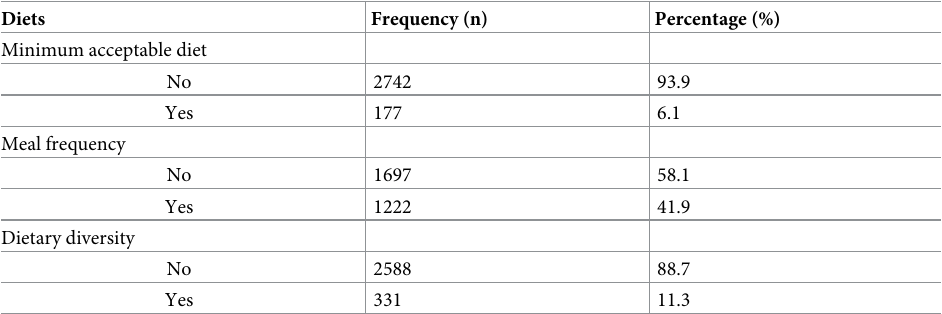
Table 4. Minimum meal frequency, Dietary diversity and minimum acceptable practice among children 6–13 months of age in Ethiopia, 2016 (n = 2919). Diets Frequency (n) Percentage (%) Minimum acceptable diet